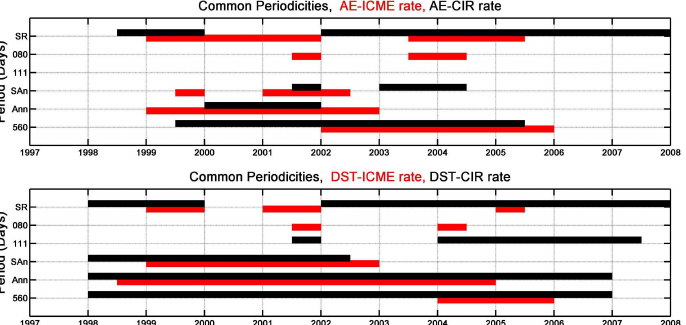
Figure 4. Common periodicities between geomagnetic indices (AE in the upper panel and DST in the lower panel) and drivers, as detected by the XWT. The red lines correspond to ICMEs and the black to CIR. The y-axis labels SR, SAn and Ann stand for Solar Rotation, Semi-Annual and Annual periodicities. Source: Katsavrias et al. 2016